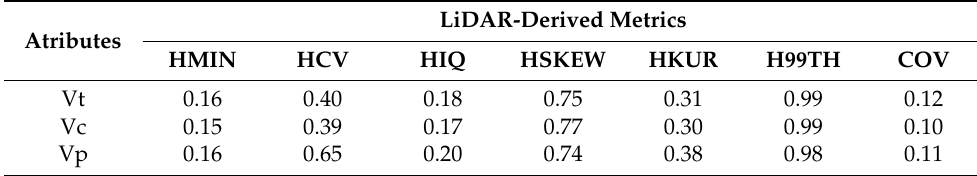
Table 6. Mean of the model improvement ratio (MIR) among the remained lidar-derived metrics not highly correlated. The bold represents the highest MIR values.